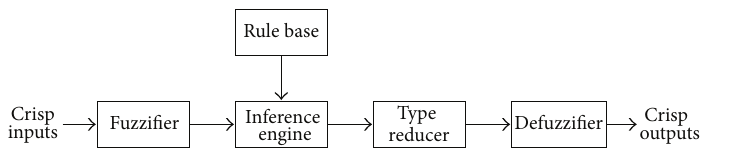
Figure 14: Interval type-2 fuzzy logic processing. Table 1: Target detection scenario values.